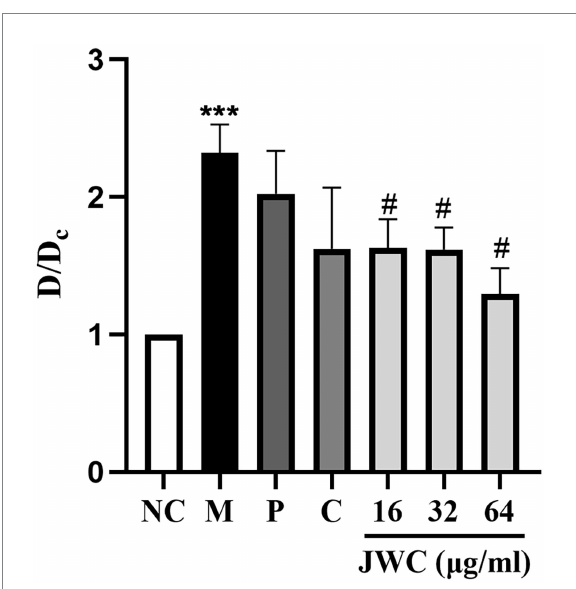
FIGURE 3 Effect of JWC, efflux pump inhibitors and MTZ on the biofilm of H. pylori 26,695–16R. Dc is the OD value of the blank control group, and D is the OD value of the other groups. NC: the blank control group, culture medium without H. pylori 26,695–16R; M, Model group, culture medium with H. pylori 26,695–16R; P, Pa β N (20 μ g/ml); C, CCCP (1 μ g/ml). *** p < 0.001, compared with the results of the control group. # p < 0.05, compared with the results of the model